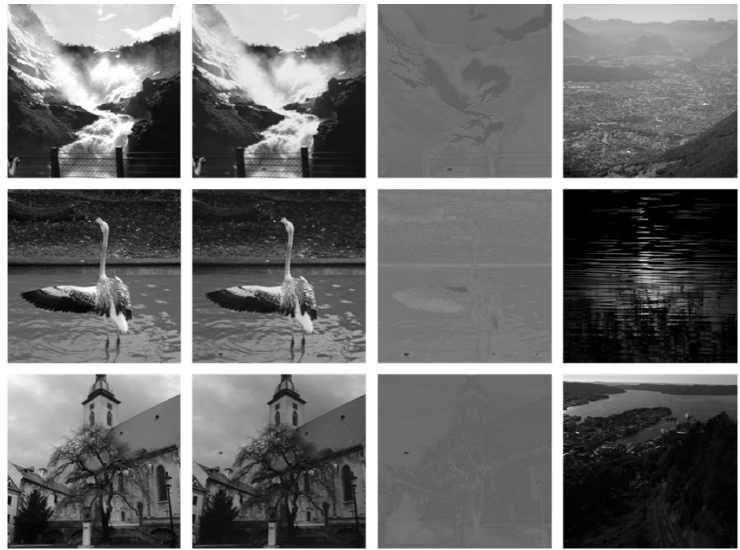
Figure 6. Samples generated by Baluja-Net from several categories in BOSSBase dataset. The first column is the original cover image. The second column is the stego images. The third column is the difference value between the stego image and cover image. The fourth column is the secret image that embedded with the cover image to make a stego image.